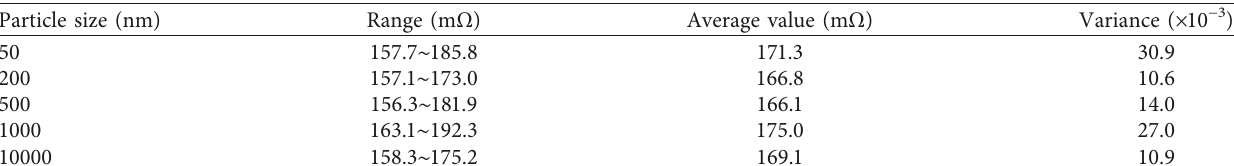
2 /Fe 2 O 3 contact material.